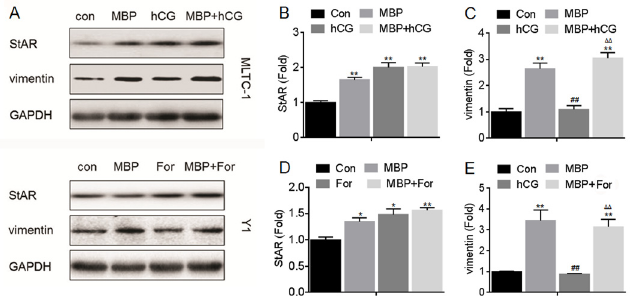
Fig 4. Effects of MBP and hCG/For on the expressions of StAR, p450scc, 3 β -HSD, vimentin, β -actin, and tubulin. MLTC-1 and Y1 cells were exposed to1000 nM MBP in the absence or presence of 100 U/L hCG or 10 μ M forskolin for 24 h, respectively. (A) Western blots analysis and relative protein levels of (B) StAR, (C) p450SCC, (D) 3 β -HSD, (E) vimentin, (F) β -actin, and (G) tubulin. ** p < 0.01 compared with medium control cells; ## p < 0.01 compared with cells treated by MBP alone; ΔΔ p < 0.01 compared with cells treated by hCG or For